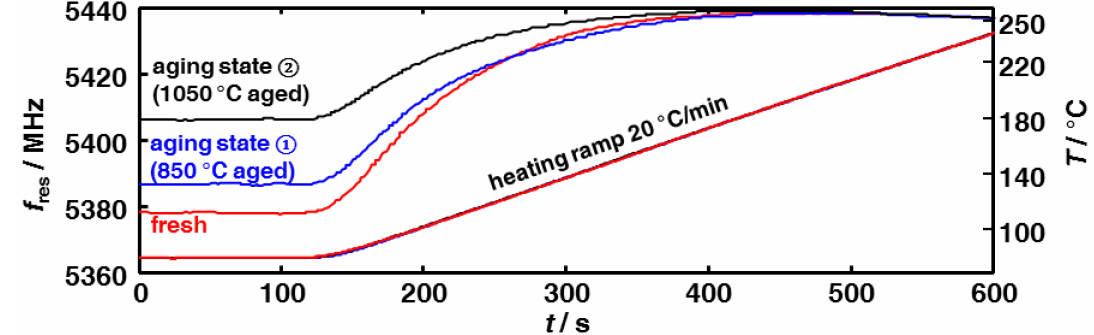
Figure 4. Resonance frequencies of a fresh ( red ), at 850 °C aged ( blue , aging state ① ) and at 1050 °C aged ( black , aging state ② ) TWC-sample at the beginning of light-off tests with a ramp of 20 °C/min and a constant lean feed gas of λ = 1.02 as well as the corresponding feed gas